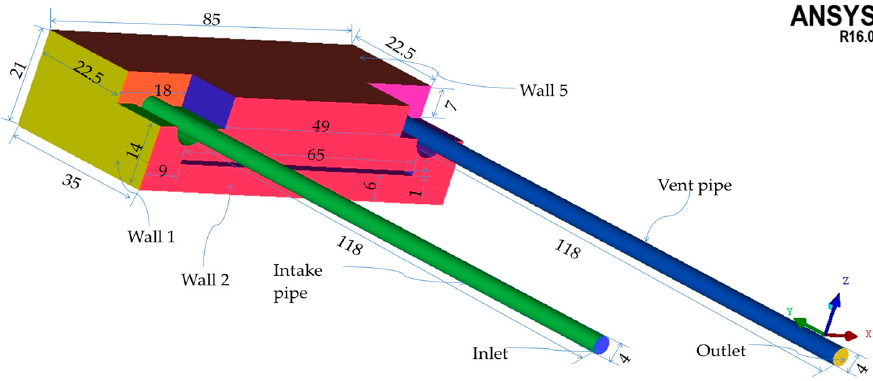
Figure 8. Global view of the sensor box’s cavity.